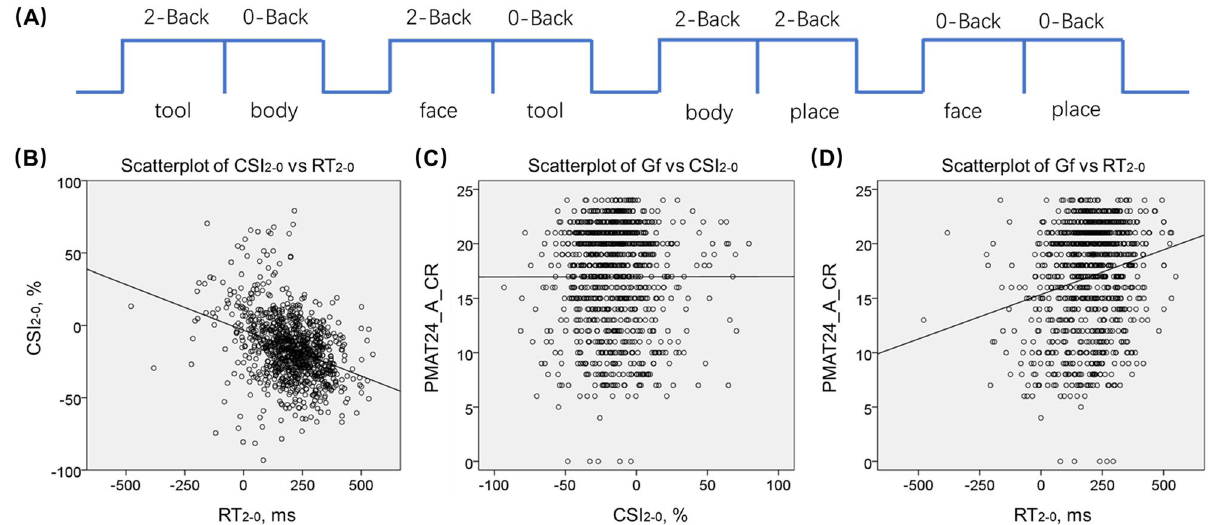
Figure 1. N-back task and the correlation of CSI 2–0 (%) and RT 2–0 (ms) with Gf. ( A ) Block sequence of the first run of the N-back task. Linear regression of ( B ) the difference in critical success index (CSI) vs. the difference in reaction time (RT) of correct trials between 2- and 0-back: CSI 2–0 vs. RT 2–0 ( r = -0.350, Cohen’s f 2 = 0.140, p = 1.1588 × 10 –28 ); ( C ) Gf, as indexed by PMAT24_A_CR vs. CSI 2–0 ( r = 0.006, Cohen’s f 2 = 3.6 × 10 –5 , p = 0.847); and ( D ) PMAT24_A_CR vs. RT 2–0 ( r = 0.155, Cohen’s f 2 = 0.0246, p = 0.000002), with age, sex, and years of education as covariates. Each data point represents one subject. B, C and D were generated by SPSS Statistics 22.0 (https:// www. ibm. com/ suppo rt/ pages/ spss- stati stics- 220- avail able- downl